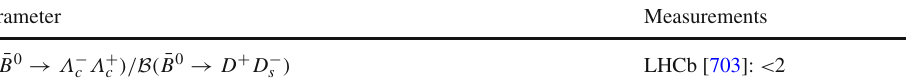
Table 128 Relative decay rates to charm baryons [ 10 − 3 ]